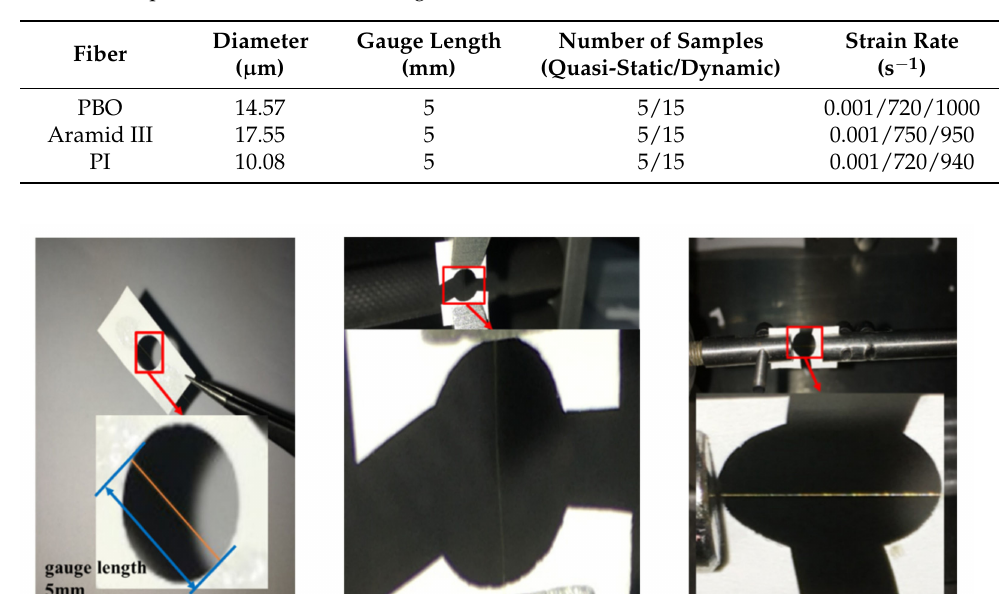
Figure 2. Three fiber categories: ( a ) PBO fiber; ( b ) PI fiber; ( c ) aramid III fiber. Table 1. Test parameters of the three single fibers.